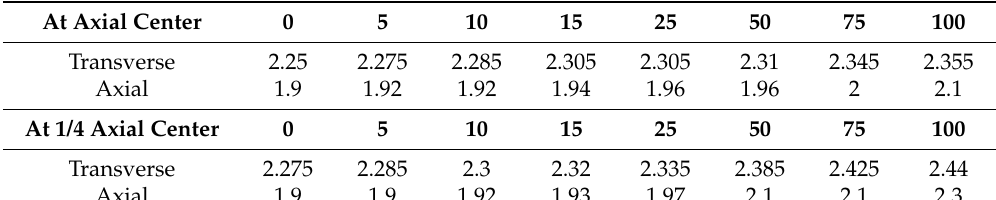
Table 6. Values of the spatial resolution at the axial center and at 1/4 of the axial center. All values are in mm.